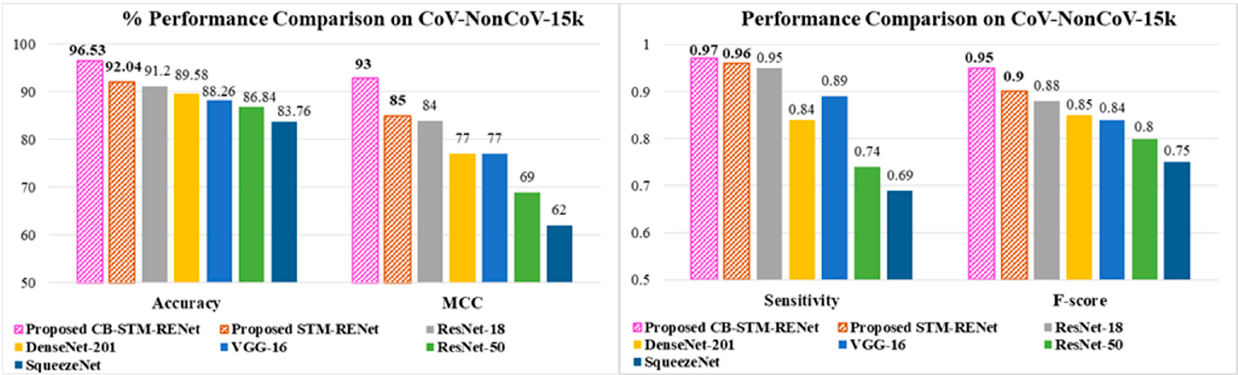
Figure 7. Performance gain of the proposed CB-STM-RENet COVID-19 detection techniques as compared with the ResNet.